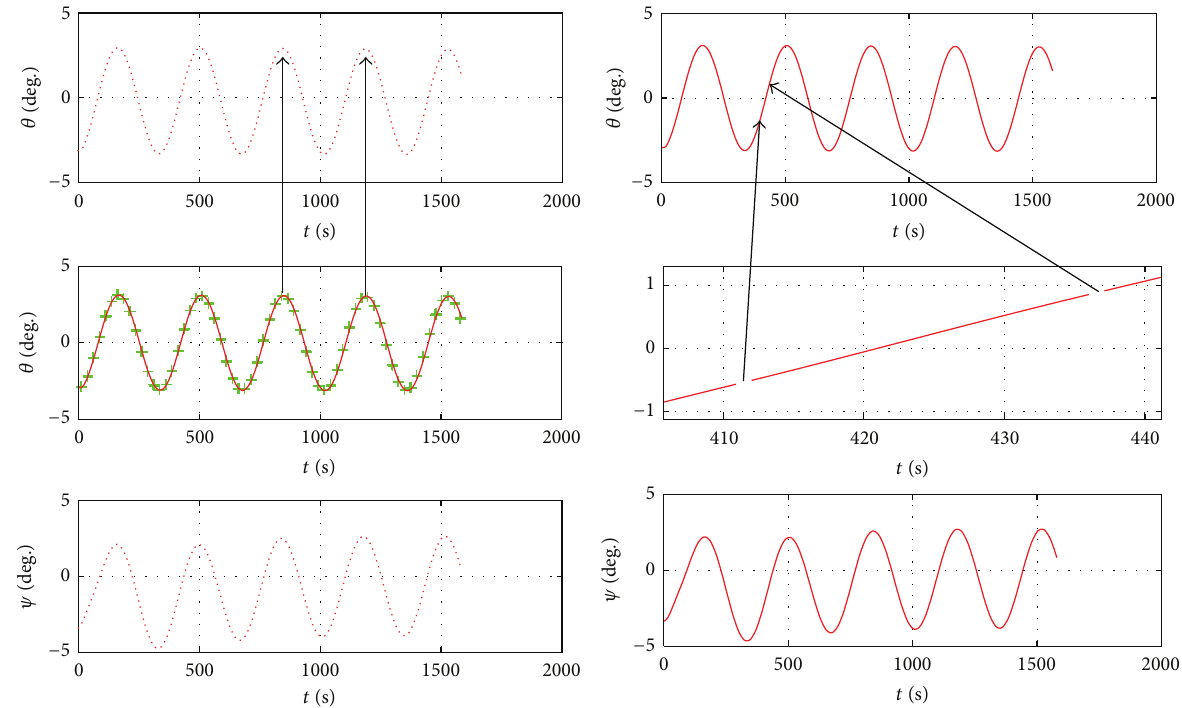
Figure 9: The equivalent expression of in-plane ( 𝜃 ) and out-plane ( 𝜓 ) librations.